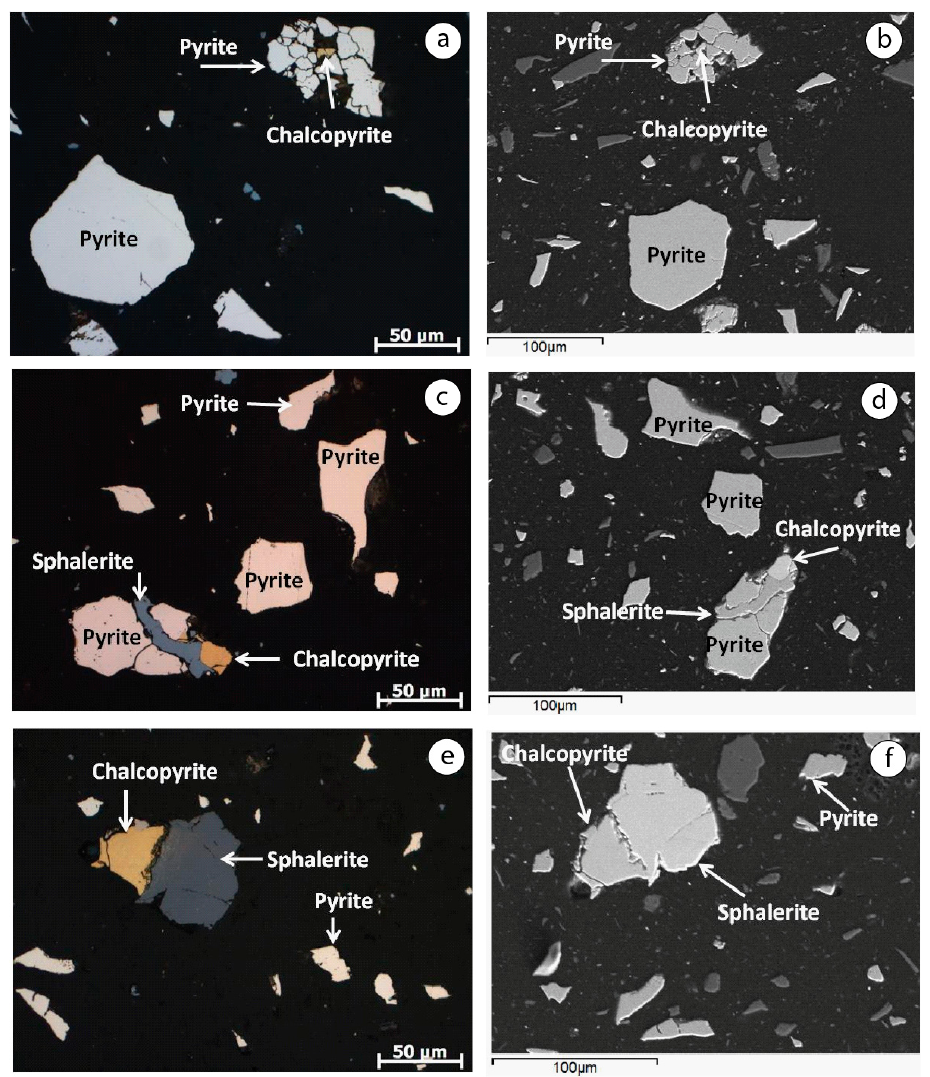
Figure 5. The identified sulfide minerals within the concentrate obtained from the flotation test; optical microscopy ( a , c , e ) and scanning electron microscopy (SEM) ( b , d , f ).